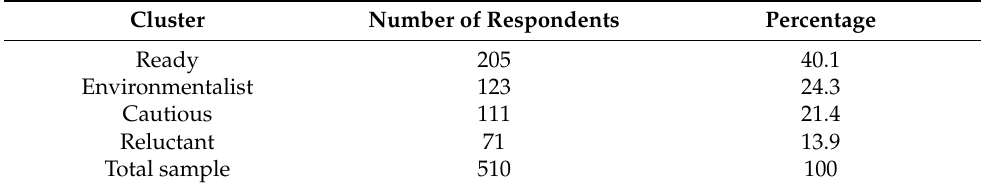
Table 3. Cluster obtained from answers to question on the willingness to buy and eat IFH